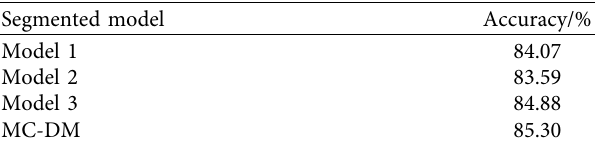
Table 3: Training accuracy